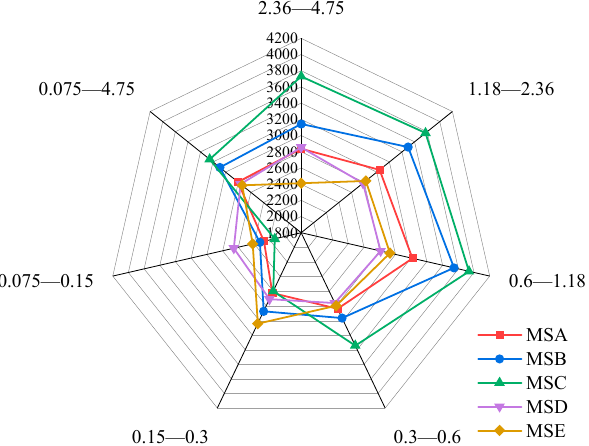
Figure 8. Mean values of angularities of five manufactured sands.